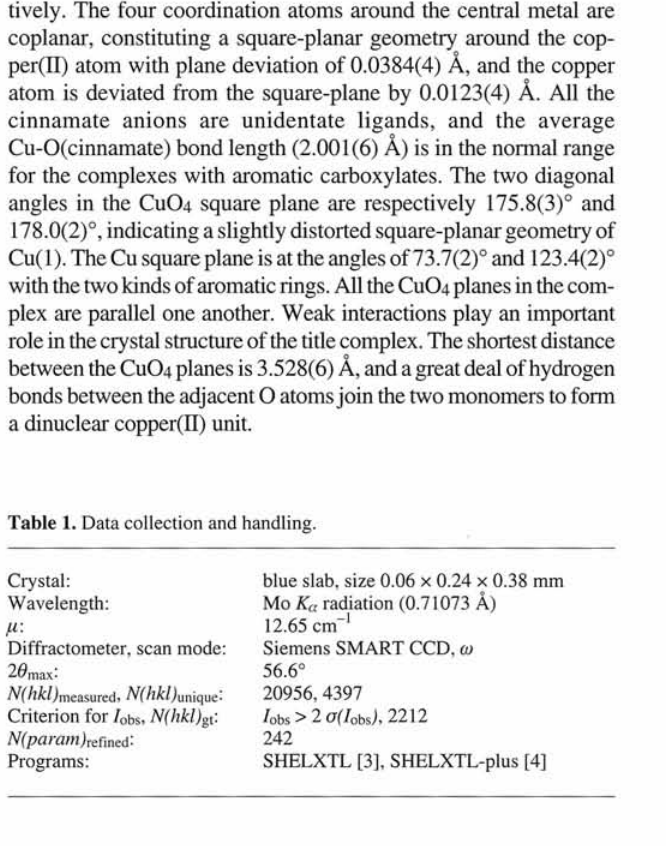
Table 2. Atomic coordinates and displacement parameters (in Á 2